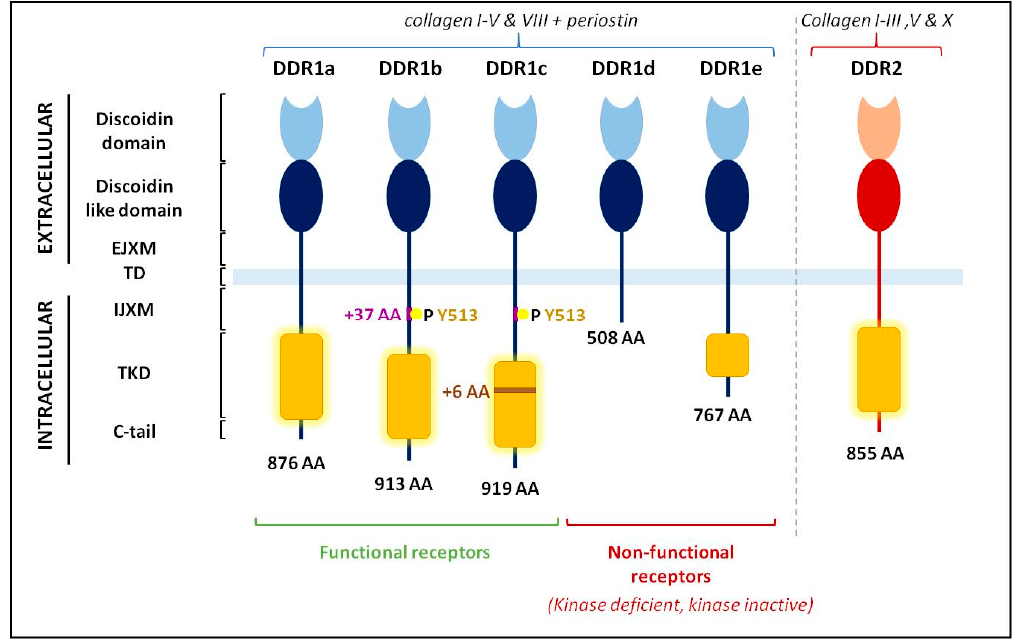
Figure 4. Schematic representation of the five discoidin domain receptor 1 (DDR1) isoforms and of the only DDR2 form. EJXM: extracellular juxta-membrane domain, TD: transmembrane domain, IJXM: intracellular juxta-membrane domain, TKD: tyrosine kinase domain, C-tail: C-terminal part of the receptors. Adapted from [12,17].